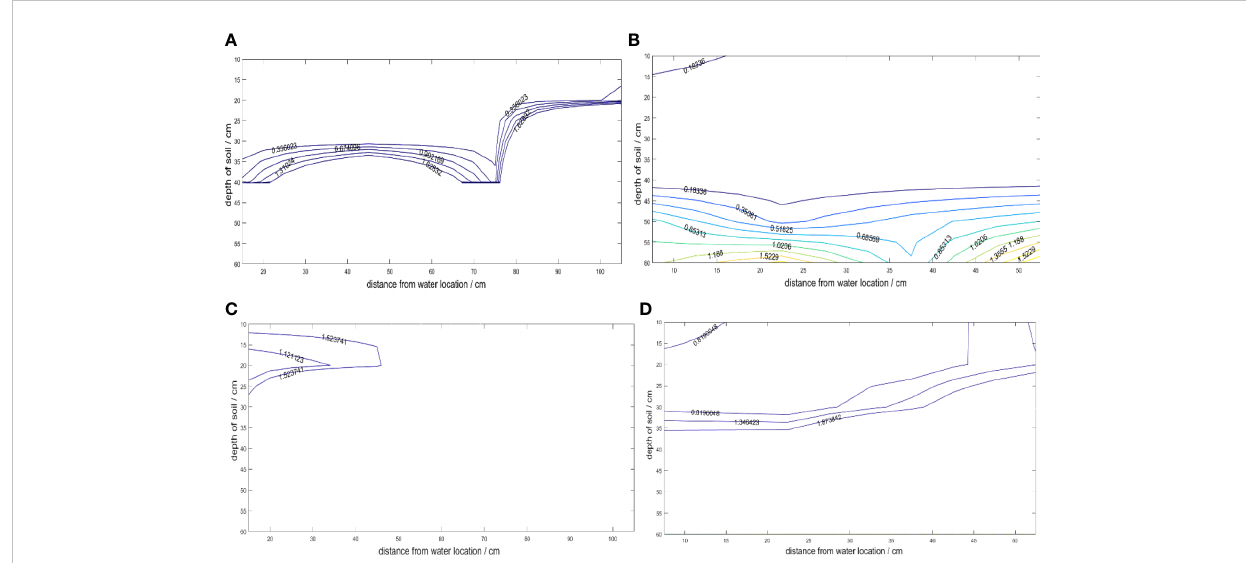
FIGURE 4 Contour map of soil water suction (MPa). (A) Flowering and Boll stage 12h after irrigation in 30-cm planting spacing. (B) Flowering and Boll stage 12h after irrigation in 15-cm planting spacing. (C) Flowering and Boll stage 3d after irrigation in 30-cm planting spacing. (D) Flowering and boll stage 3d after irrigation in 15-cm planting spacing.